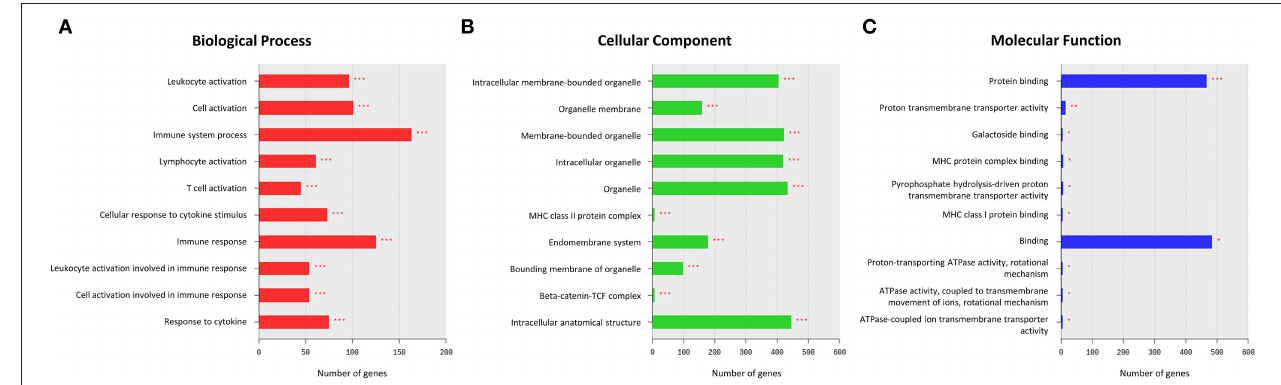
FIGURE 2 | Results of a Gene Ontology (GO) enrichment analysis of downregulated differentially expressed genes (DEGs) in the MD group. The top enriched GO terms for the biological process (BP) (A) , cellular component (CC) (B) , and molecular function (MF) (C) are shown. The x -axis represents the number of genes enriched in each GO term. The y -axis represents GO terms with adjusted p -values of < 0.05 ( * ), < 0.01 ( ** ), and < 0.001 ( *** ).